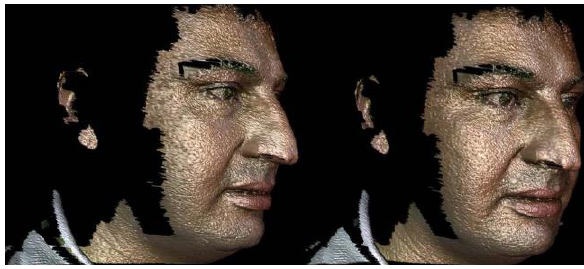
Figure 8. An experimental re-construction from TLS data To test data acquisition, in small scale, experimental TLS